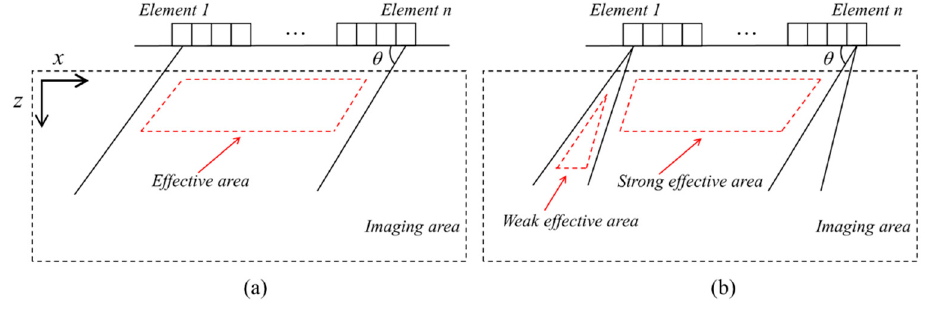
Figure 2. The effective area of plane wave imaging (PWI) at ( a ) θ angle ( b ) multi-plane wave mode.